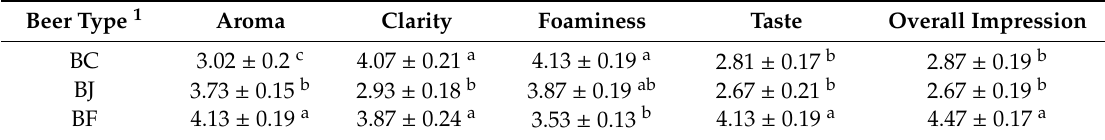
Table 4. Organoleptic analysis of tested beers.